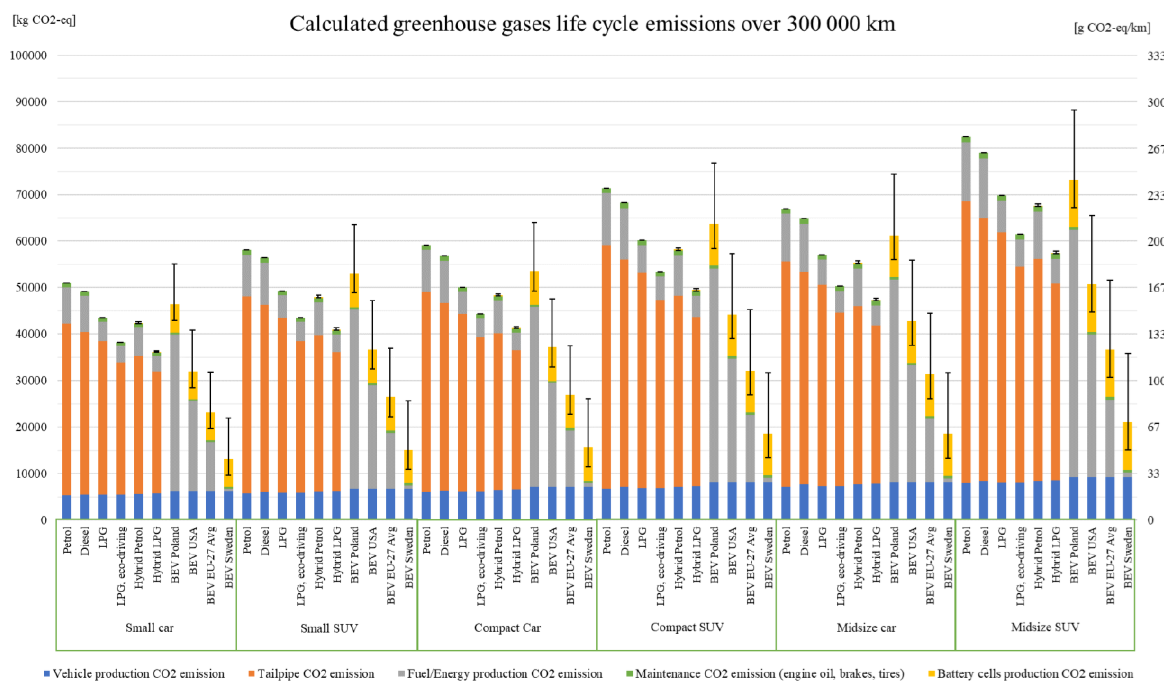
Fig. 1. Calculated greenhouse gases life cycle emissions of passenger vehicles over 300 000 km